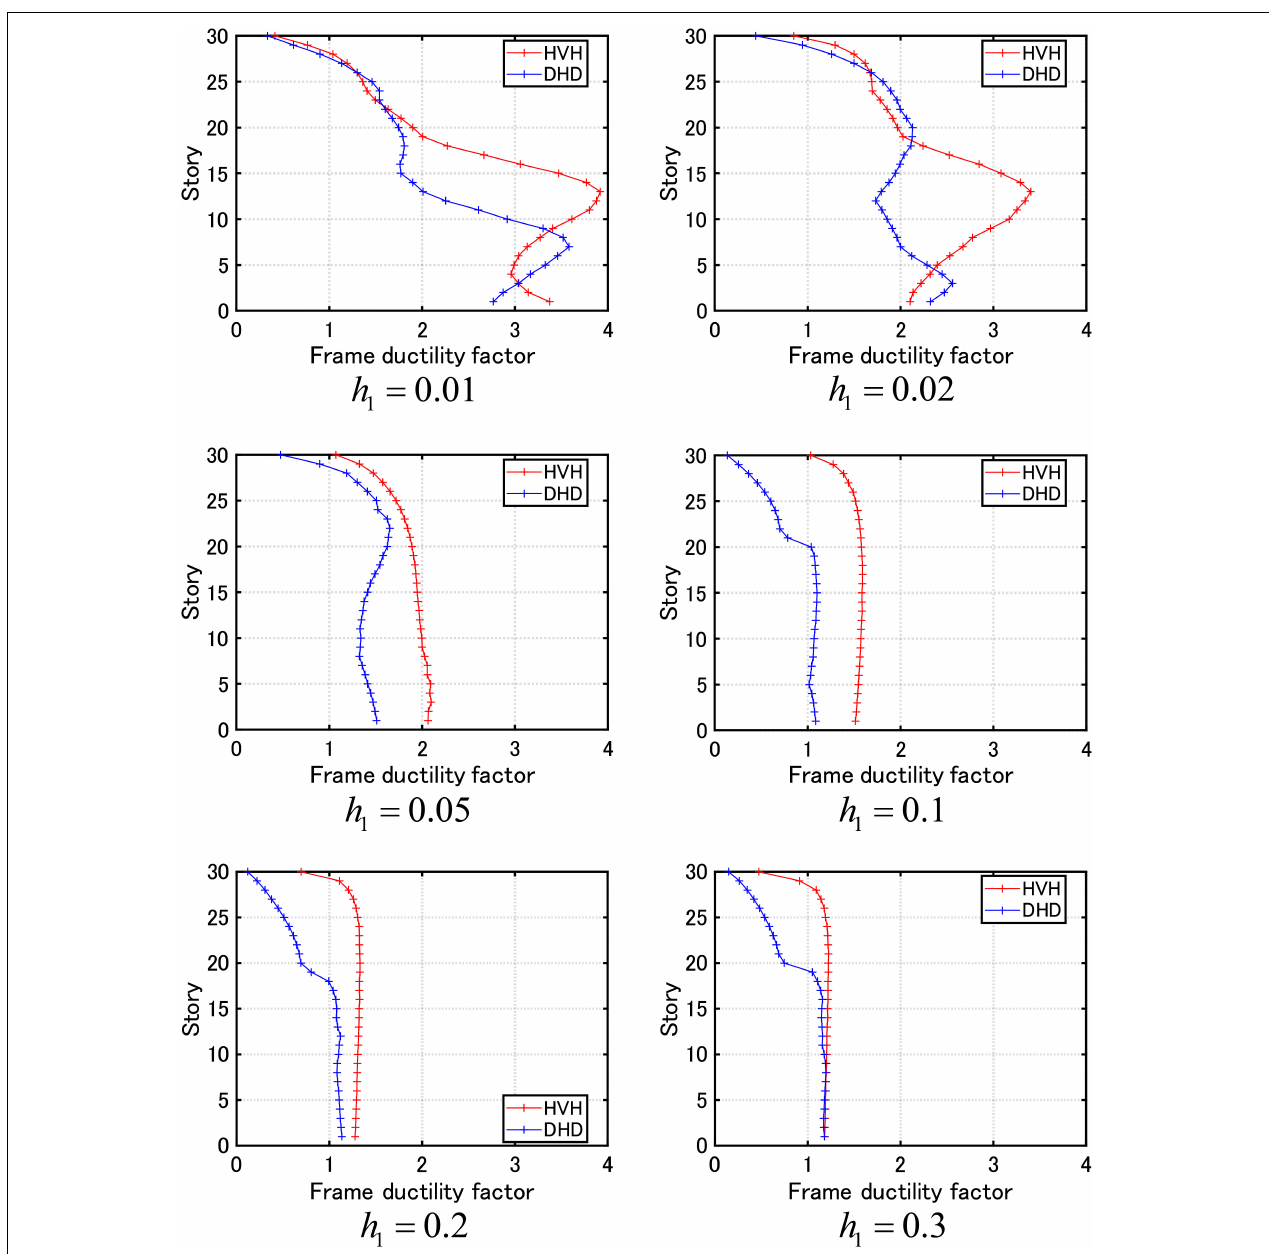
FIGURE 13 | Frame ductility factor distribution of inter-story drift in MDOF systems with HVH system for various damping levels h 1 = 0 . 01 , 0 . 02 , 0 . 05 , 0 . 1 , 0 . 2 , 0 . 3 of viscous dampers and with DHD system of equivalent damper quantity of DSA (using Eq. (4) for V = 1.0 (m/s)) under JMA Nishiharamura-Komori (EW)